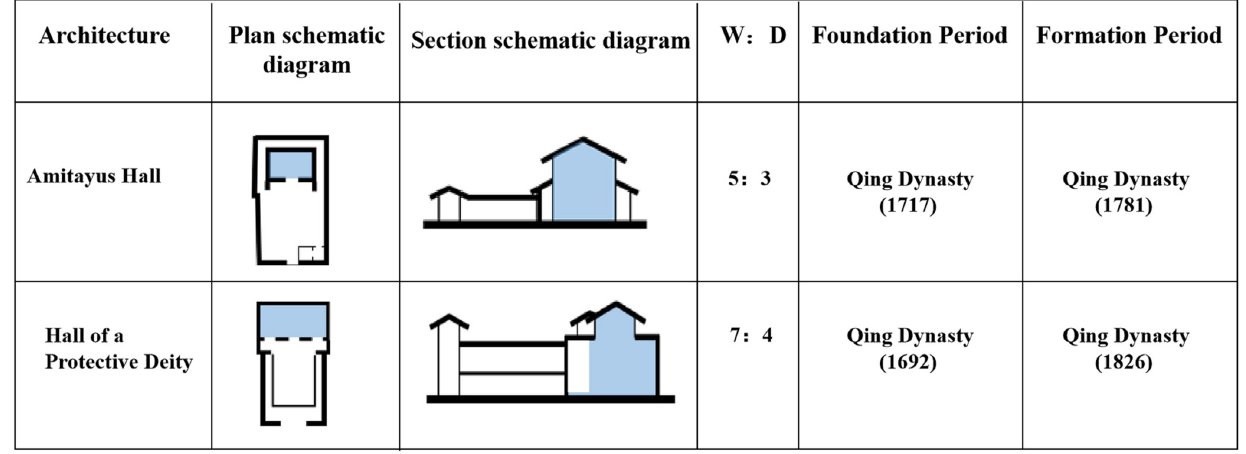
Fig 12. Spatial features of the palace buildings of type 4. (W, width of the Palace Halls; D, depth of the Palace